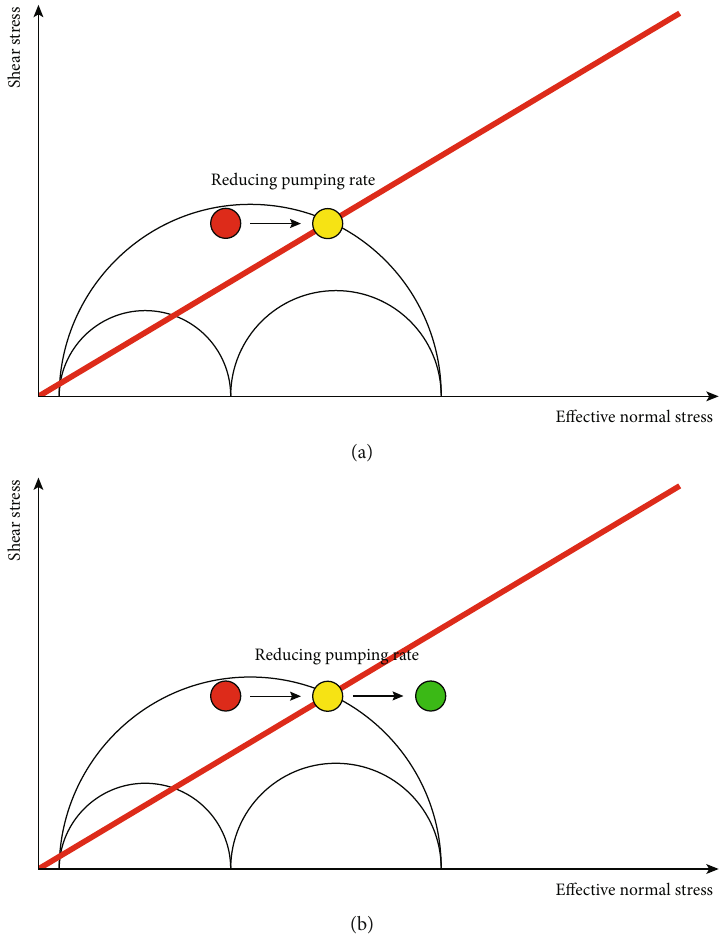
Figure 19: The stress state change of two types of faults under reduced pumping rate condition: (a) high-risk fault; (b) medium-risk